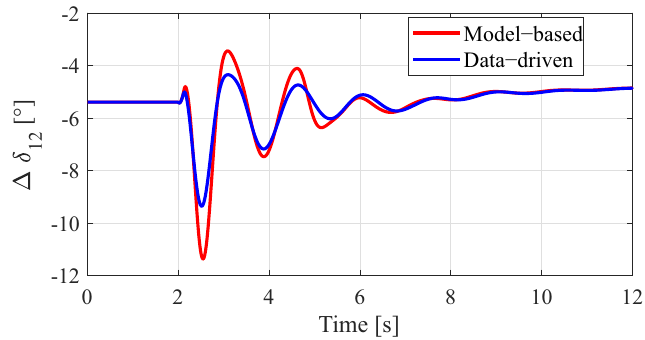
Figure 11. Rotor angles during a fault at Bus 7.